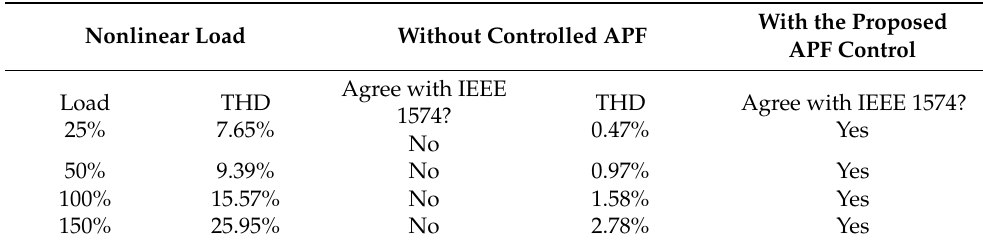
Table 4. THD and agree/disagree with IEEE 1547 standard without and with controlled APF against load